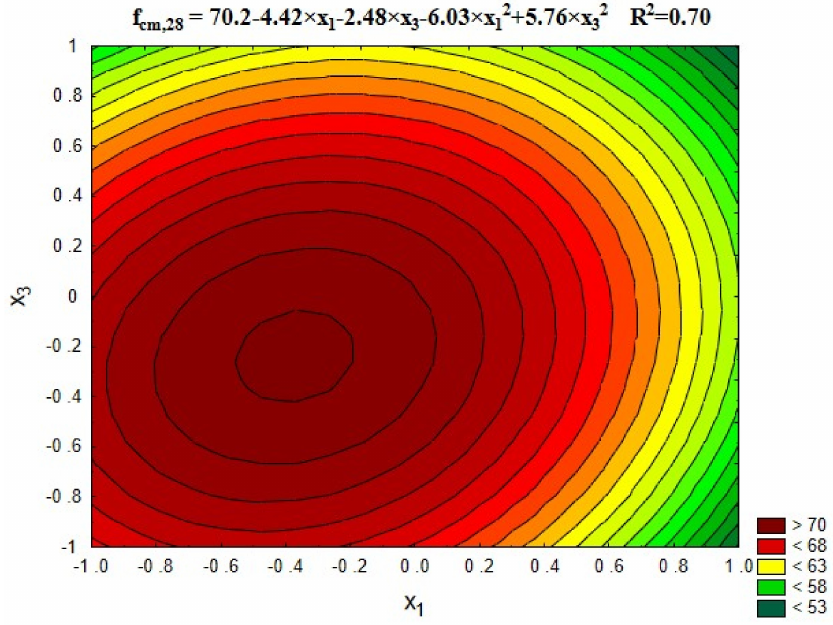
Figure 3. The changes in compressive strength of concrete, depending on x 1 and x 3 (x 2 =